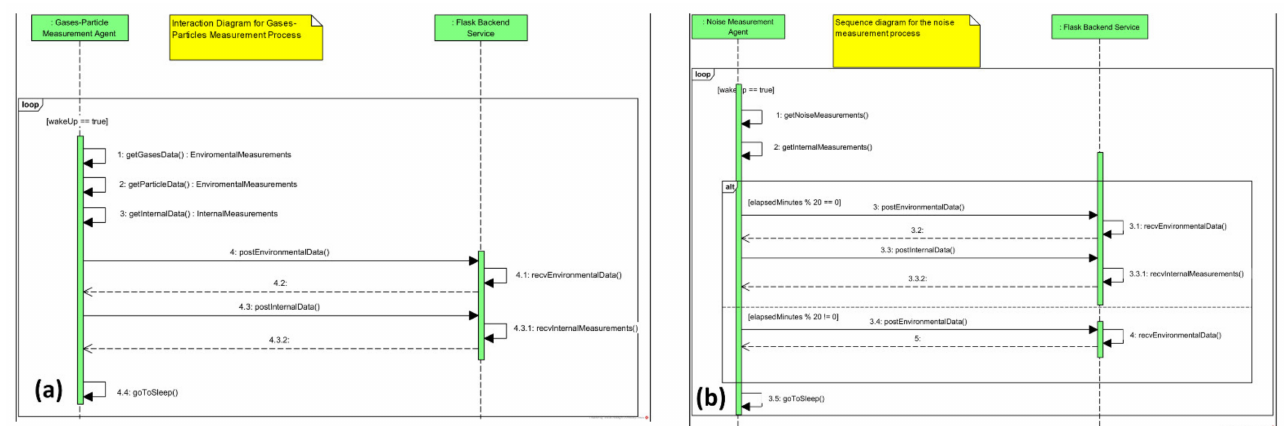
Figure 3. Sequence diagram between the OD platform and the IoT devices: ( a ) air quality IoT device; ( b ) noise IoT